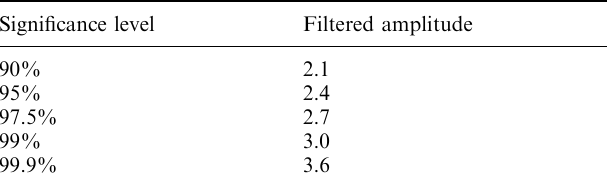
Table 1. Significance levels computed via Monte-Carlo simulation and the corresponding filtered